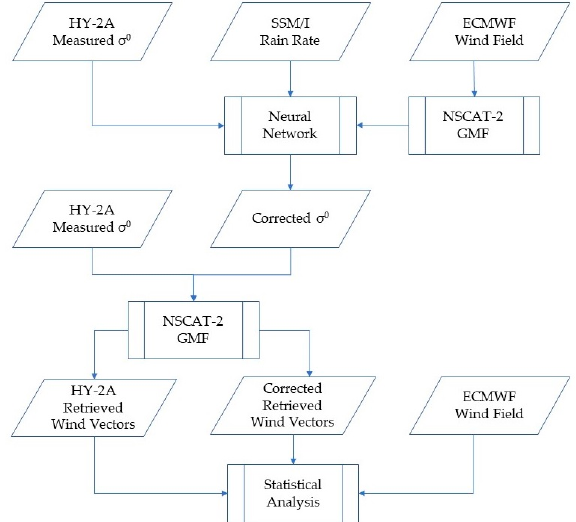
Figure 2. Flow chart of the HY-2A scatterometer neural network rainfall e ff ect